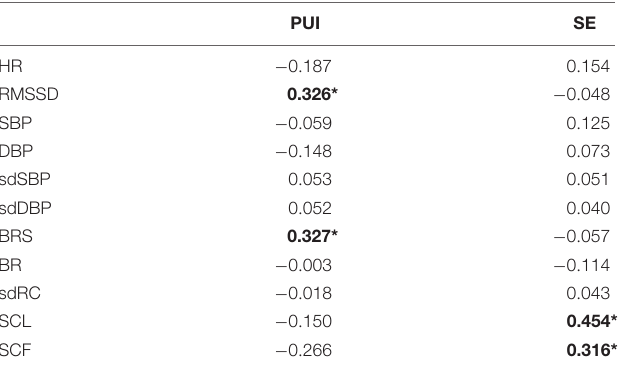
TABLE 4 | Correlation analysis of pupillary dynamics and autonomic